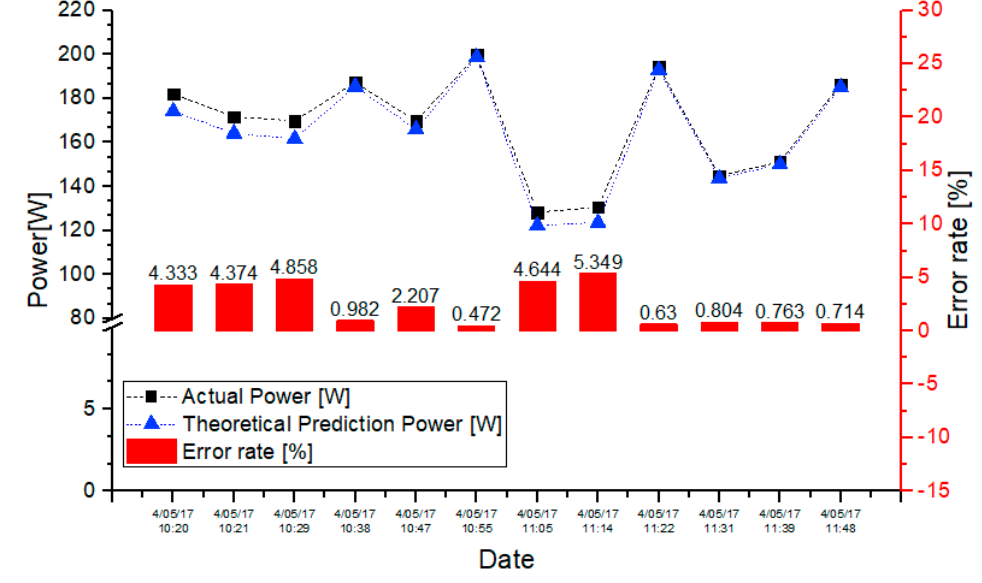
Figure 14. Experimental data of Exp. 4.